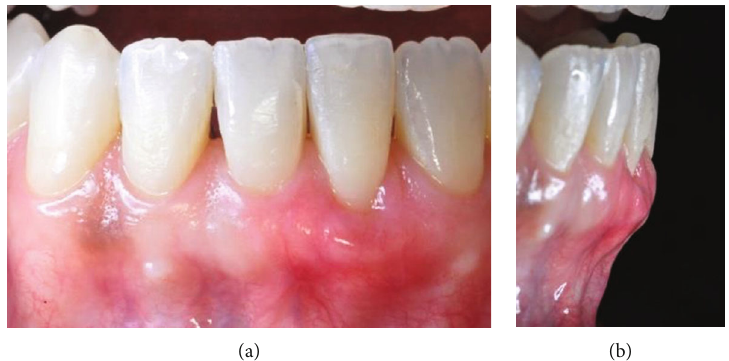
Figure 13: (a, b) 45 days postoperatively.